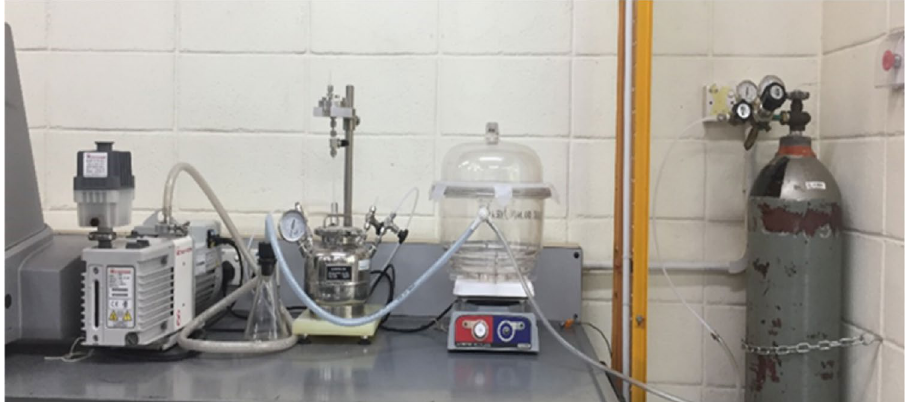
Fig. 3 De-gas (vacuum)